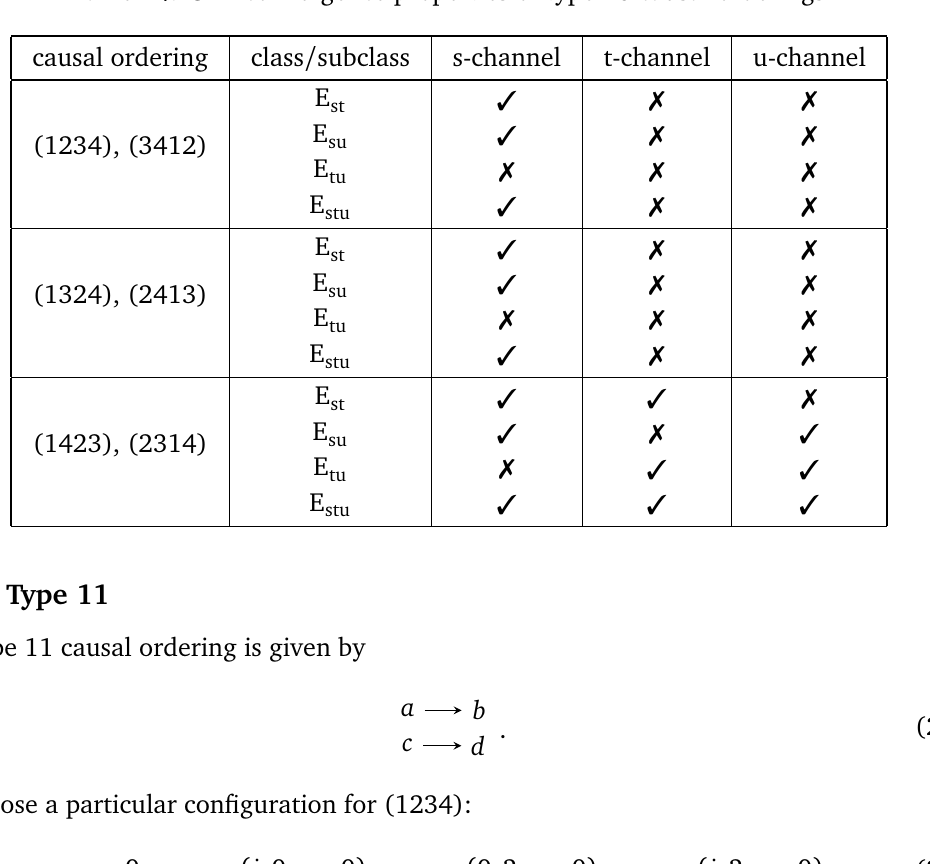
Table 14: OPE convergence properties of type 10 causal orderings